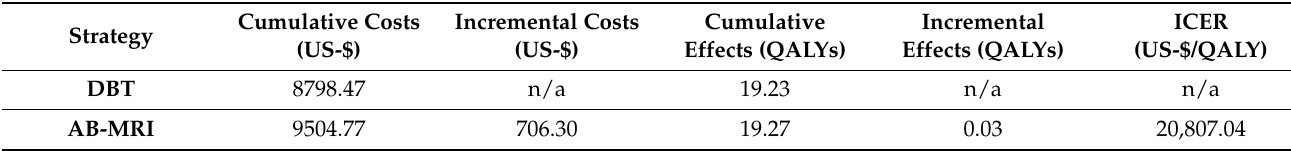
Table 1. Results of base case cost-effectiveness analysis. Discounted average cumulative costs and effects were modeled for